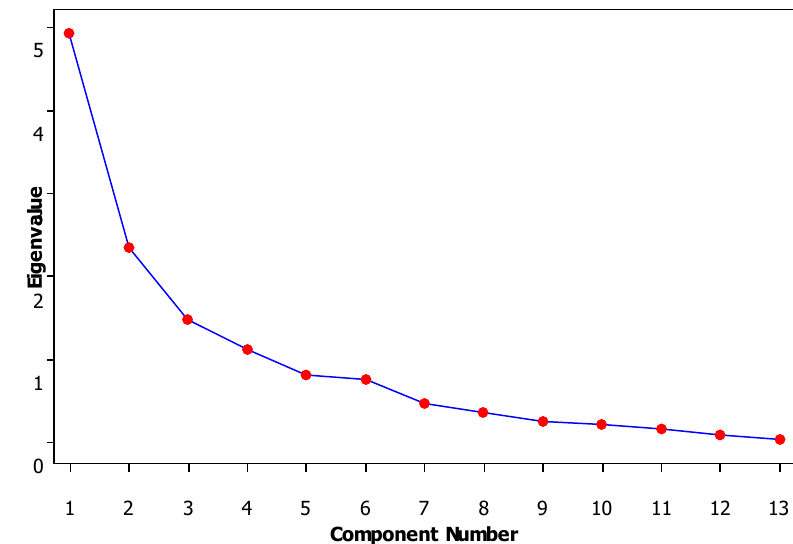
Figure 4. Scree plot of Eigen values of the principal components.